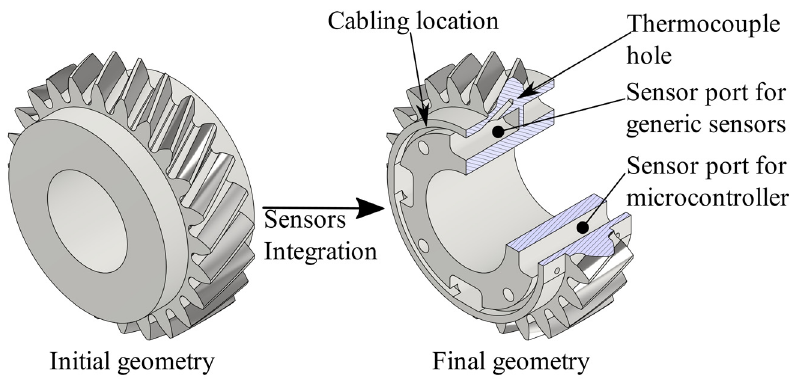
Figure 1. The proposed final gear body geometry ( left ) that has been defined by modifying the original one ( right ).